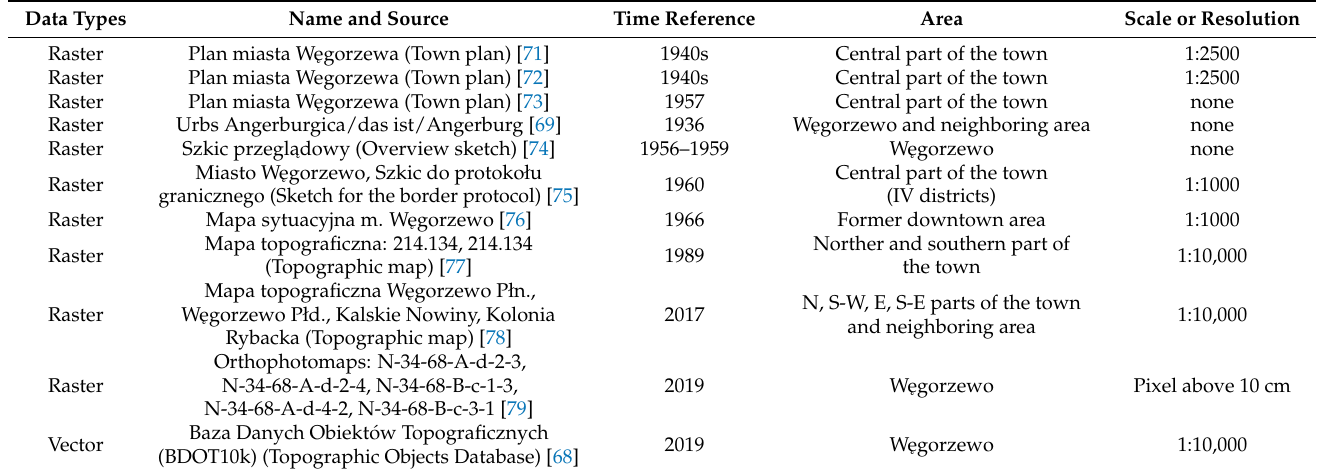
Table 1. Characteristics of data types and sources used in the